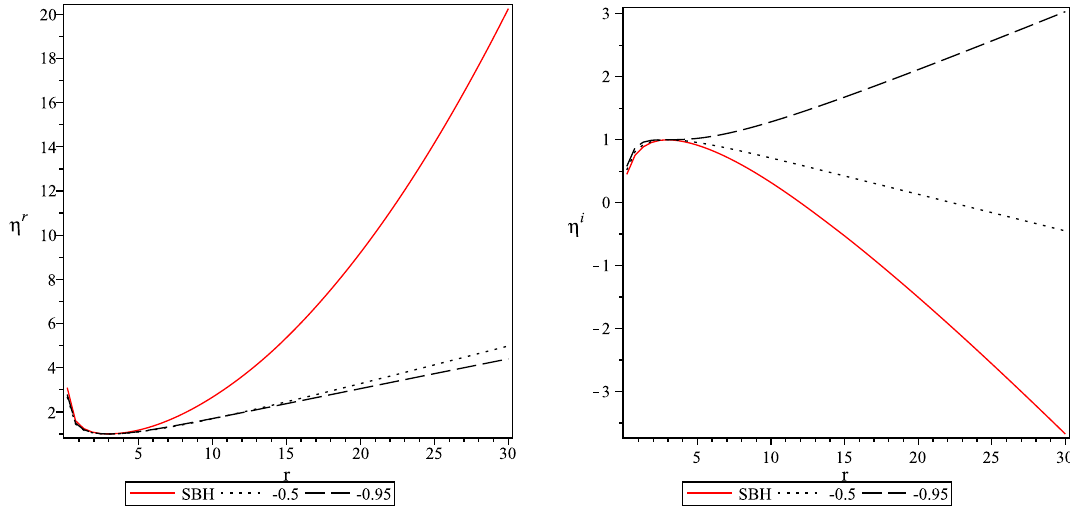
Fig. 4 Variation of geodesic vectors for M = 1, q = 0 . 05, a = 0 . 3 and different mentioned values of w q ; left figure: radial geodesic vector with ICI, right figure: angular geodesic vector with ICI; solid line curve represents the corresponding variation for